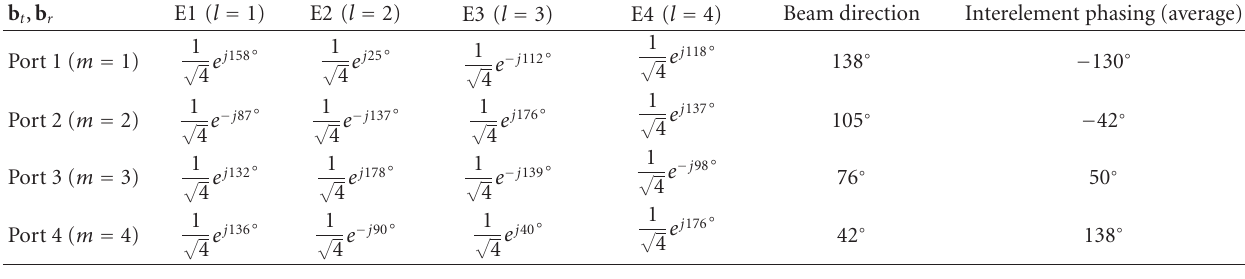
Table 5: Element phasing, beam direction, and interelement phasing for the Butler matrix shown in Figure 4 (manufactured).